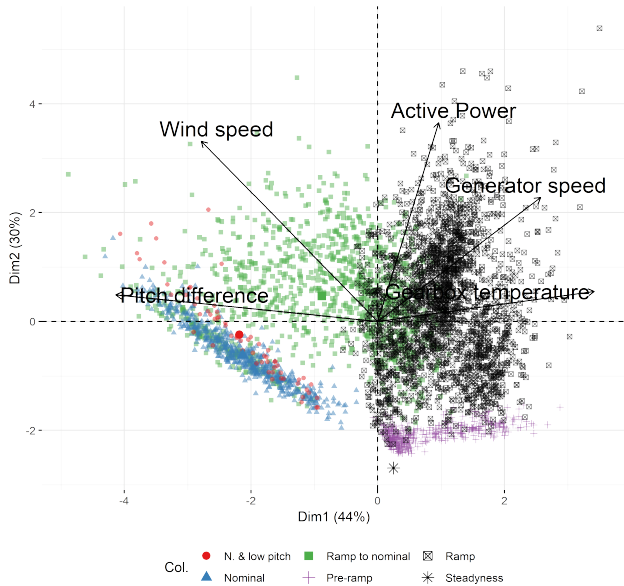
Figure 9. Example of the PCA obtained from the different OR and RMS (root mean square) values of the OS generated in WT 1.